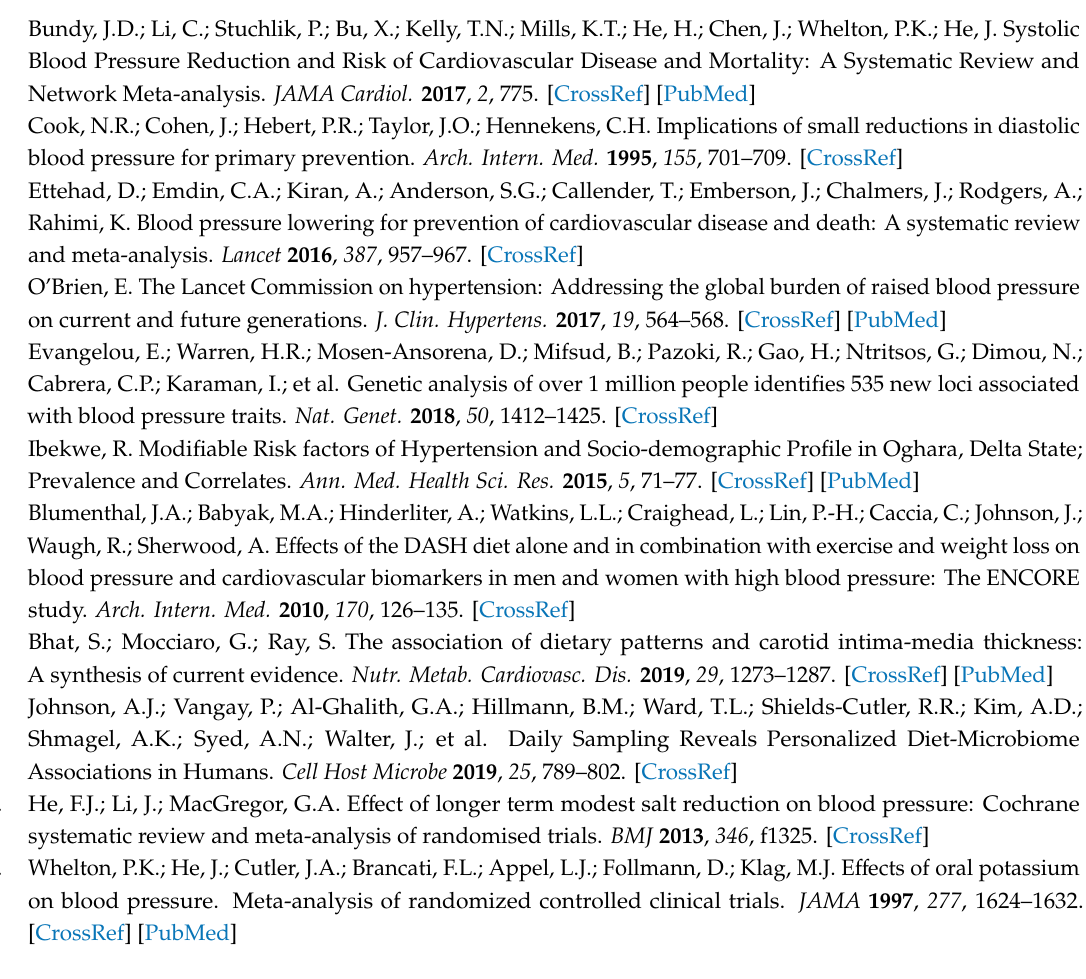
Table S1: Description of dietary indices, Table S2: Descriptive nutrient intakes of TwinsUK sample ( n = 3889 ). Mean(SD) are provided, Table S3: Nutrient e ff ects on SBP and DBP adjusted for covariates, Table S4: Dietary index’s e ff ects on SBP and DBP adjusted for covariates, Table S5: Heritability estimates of nutrient intakes adjusted for covariates, Table S6: Heritability estimates of blood pressure adjusted for